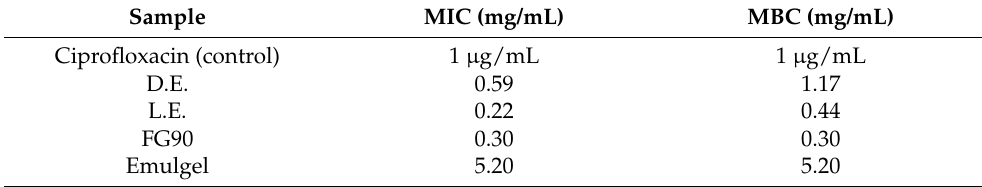
Table 5. MIC and MBC against S. pyogenes values measured for the raw materials and the